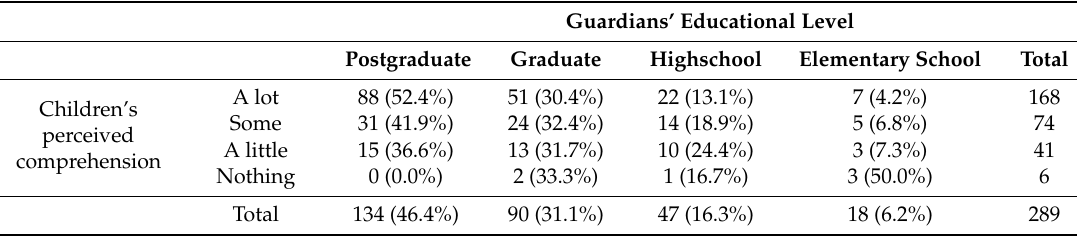
Table 3. Guardians’ educational level and children’s perceived comprehension of the COVID-19 pandemic.